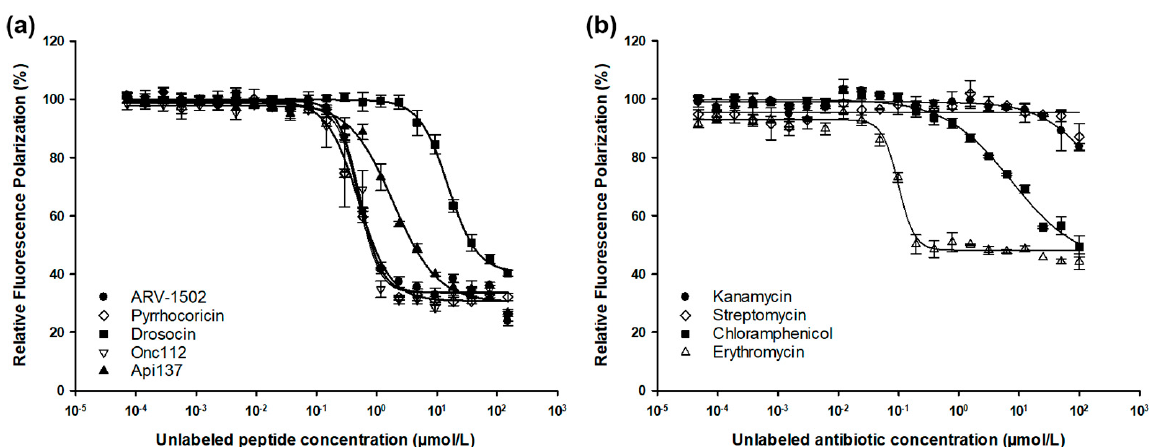
Figure 1. Fluorescence polarization assay using E. coli 70S ribosome and Cf-ARV-1502 in competition with unlabeled PrAMPs ( a ) and antibiotics ( b ). Curves were fitted to a concentration-response algorithm with a variable slope parameter [y = min + (max − min)/(1 + (x/IC50) − Hill slope )] by using SigmaPlot. Table 1. Inhibition constants (K i ) determined for E. coli 70S ribosome and Cf-labeled ARV-1502 in competition with different PrAMPs and antibiotics.